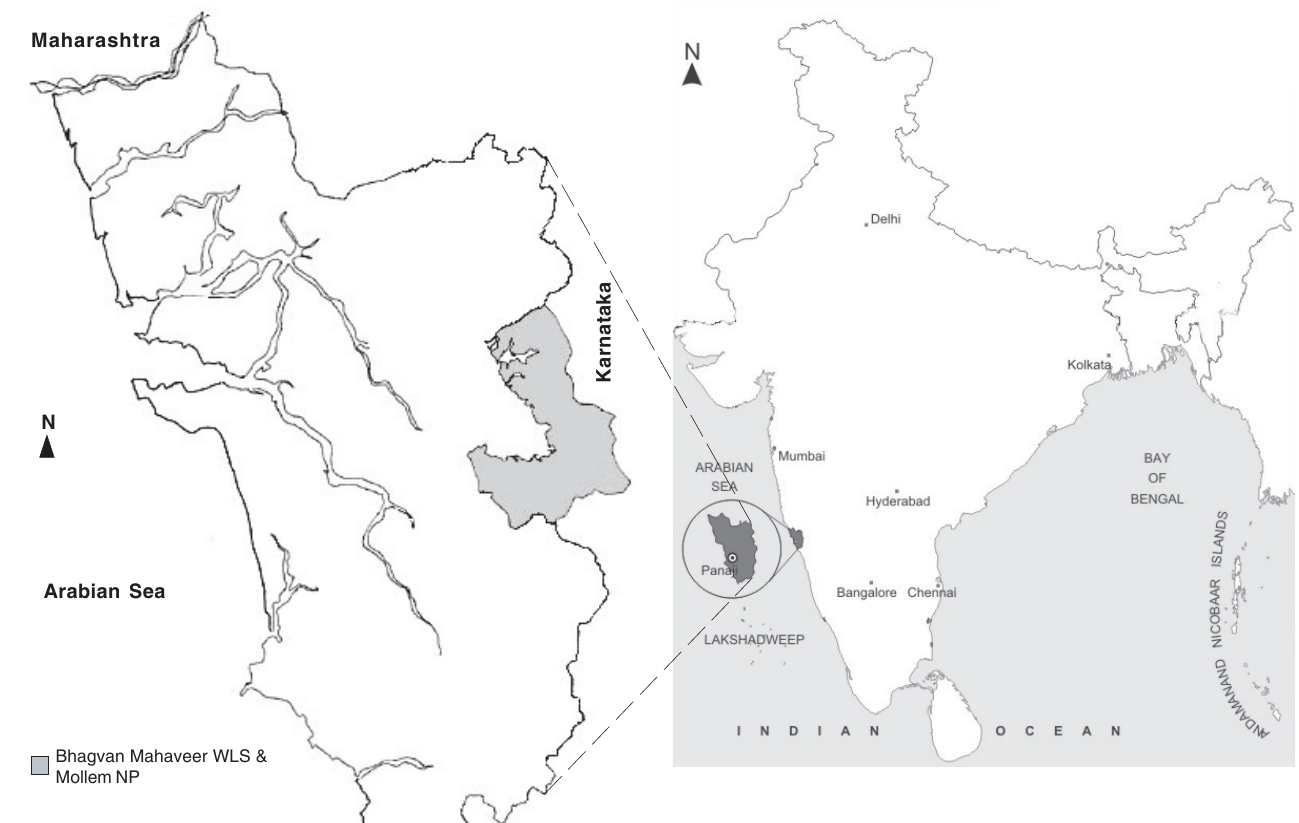
Bhagvan Mahaveer WLS & Mollem